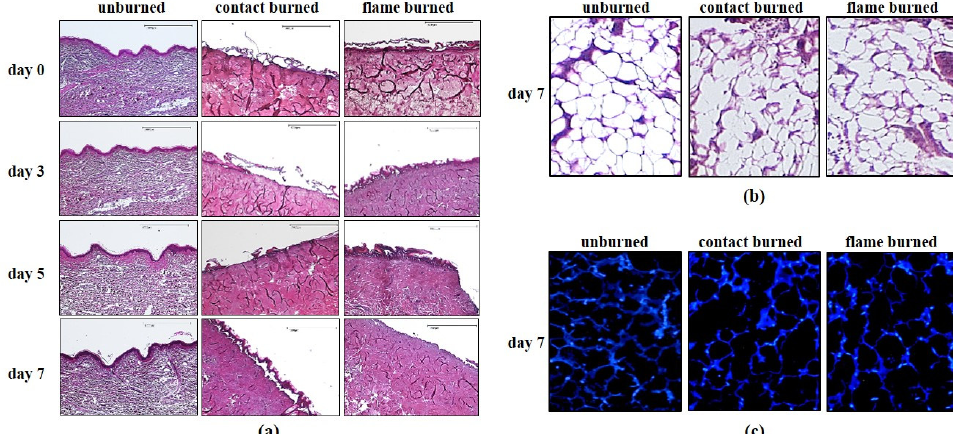
Figure 1. Comparison of tissue damage caused by contact and flame burns. Composite tissue samples from 6 different donors were subjected to contact (contact burned) burns or flame burns (flame burned) or were left untreated (unburned). Samples were either preserved immediately after injury (day 0) or further maintained in vitro for three (day 3), five (day 5), or seven days (day 7). ( a ) Tissue sections were analyzed using hematoxylin and eosin (HE) staining and viewed directly under a microscope. The images are from a single donor and are representative of 5 other healthy donors. The scale bar represents 1000 µ m. ( b ) Magnified images (600 × 800 µ m) of unburned or burned (contact or flame) HE-stained human subcutaneous adipose tissue sections 7 days after injury. ( c ) Tissue sections were analyzed using DAPI staining and observed under a fluorescence microscope. The images are from a single donor and representative of 5 other healthy